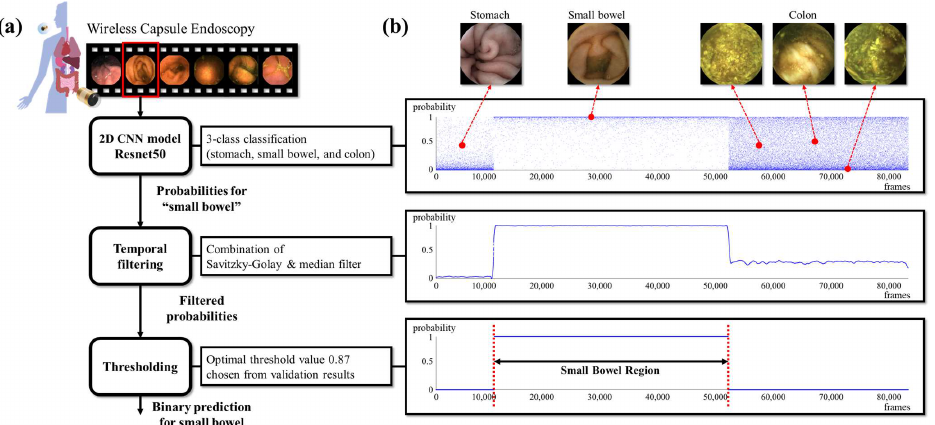
Figure 2. The code will be available on our GitHub page (https://github.com/MAILAB- yonsei).